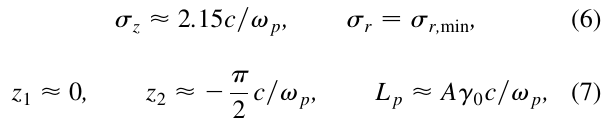
FIG. 2. (Color) (a) Values of the criterion function on the optimum curve (dots) and on the line (cid:2) (cid:1) optimum beam shape; (c) optimum beam length; and (d) optimum plasma length. Dots show the local maxima obtained numerically. Crosses mark the regime under the detailed